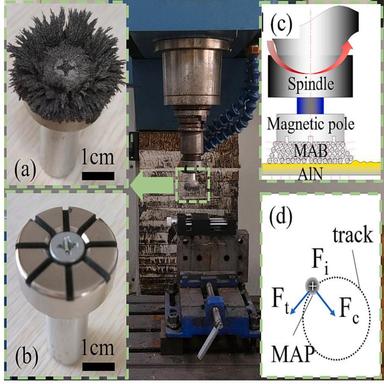
Diagram of MAF experimental equipment: (a)MAB; (b)Slotted magnetic pole; (c)Processing principle; (d)Single MAP processing force diagram: Fi-Indentation force; Ft-Tangential cutting force; Fc-Centripetal force.